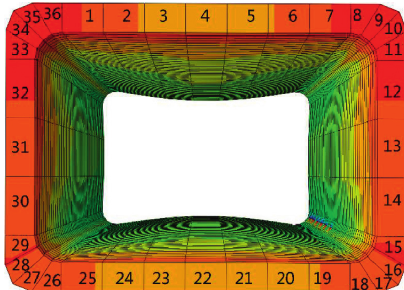
Figure 7: The indexes and locations of pipe elements (case A1).